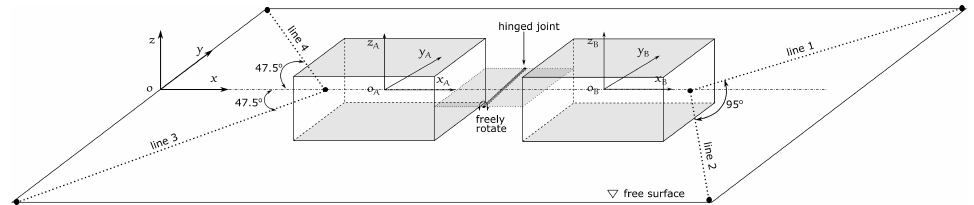
Figure 2. Illustrative representation of the numerical setup, including hinged joint and mooring